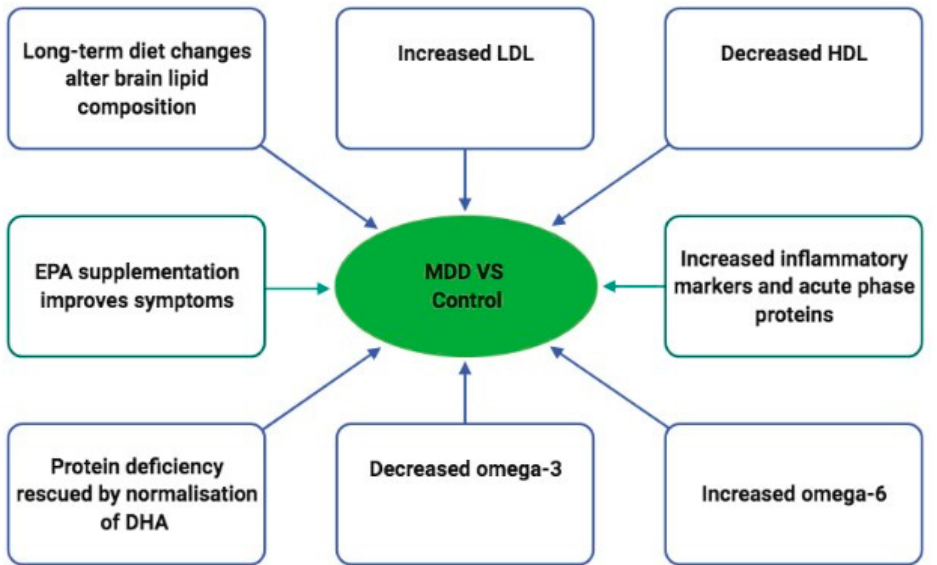
Figure 1. The figure above indicates lipid biomarkers that were found to differ between patients with depressions versus control subjects without depression. Patients with MDD show increased LDL and decreased HDL, increased inflammatory markers and omega 6 fatty acids, where decreased omega 3 fatty acids are in opposition to the healthy control group. Adapted from [12].